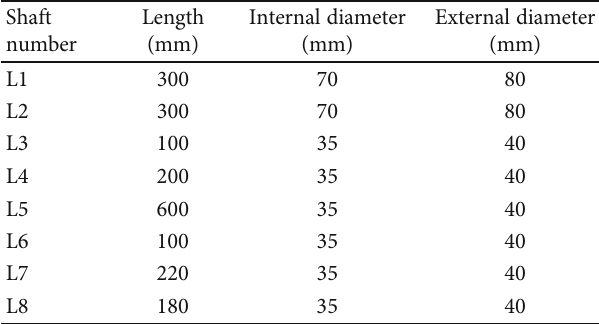
(a) Geometric parameters of a low-pressure rotor system